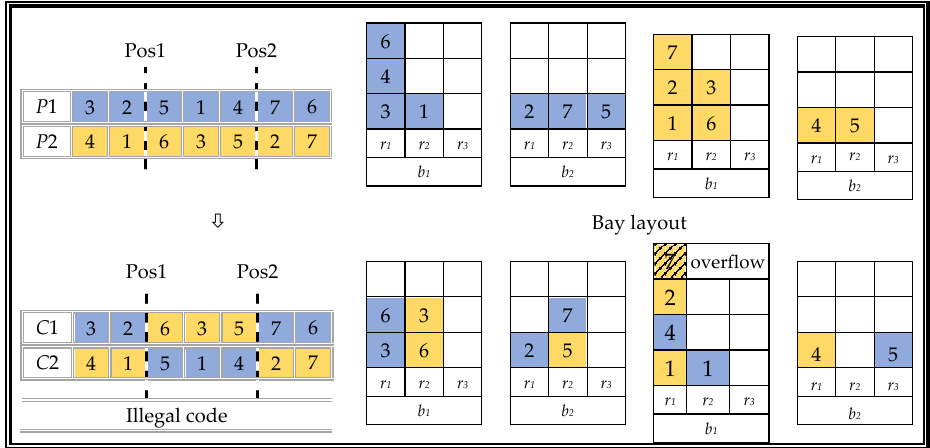
Figure 8. Illegal code generated by sequence code crossing.